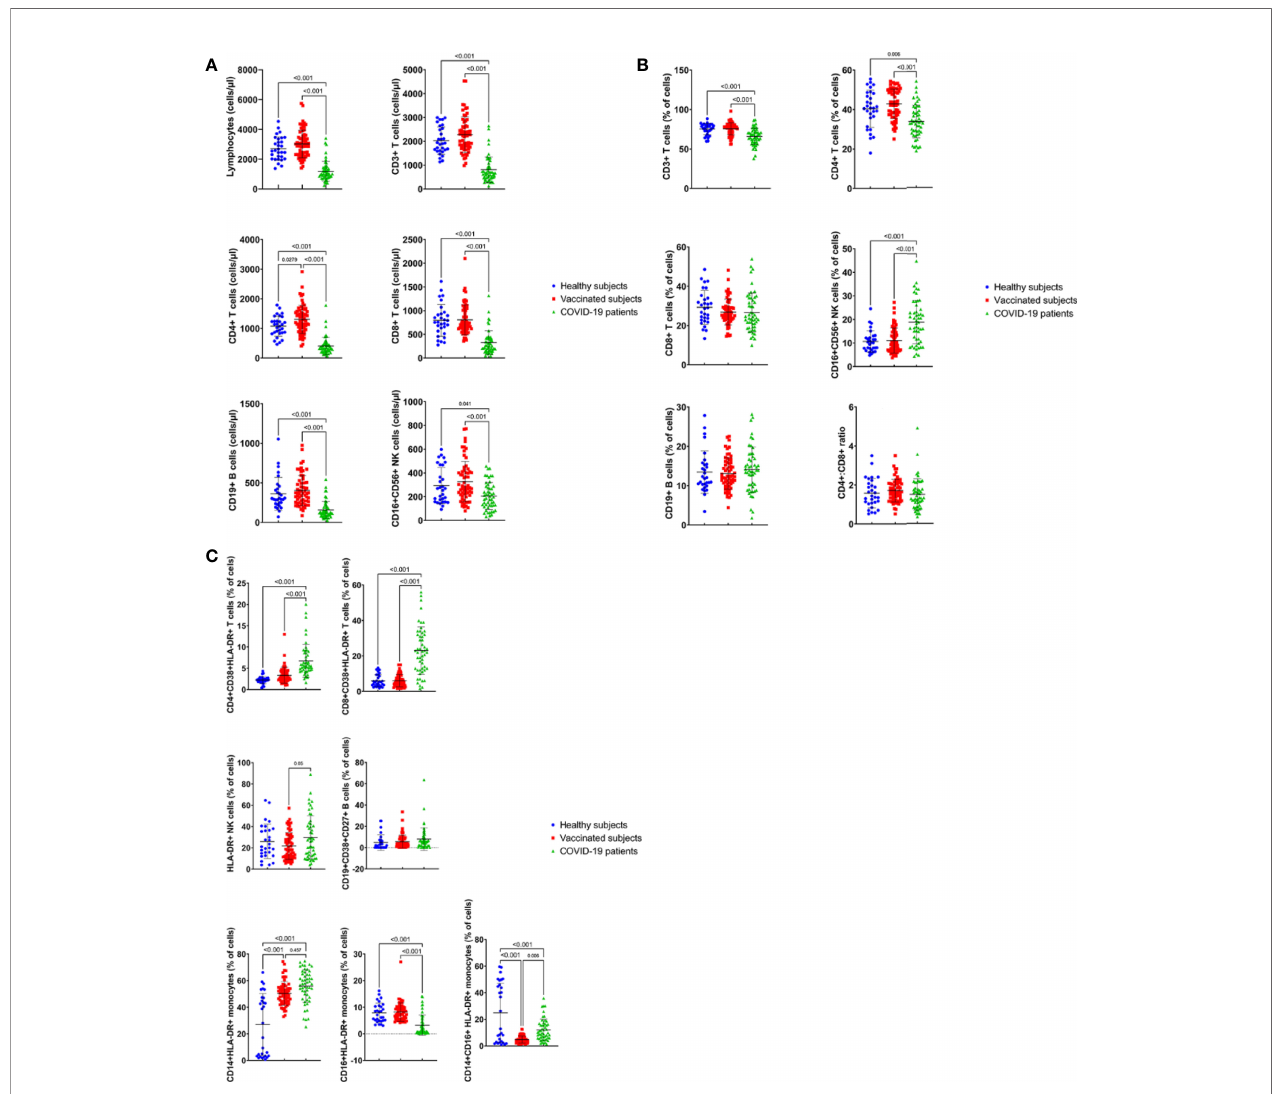
FIGURE 2 | Absolut counts (cells/ m l) (A) and percentages (B) of immune cell subsets in peripheral blood of COVID19-infected patients, healthy subjects and vaccinated subjects. Results are shown for total lymphocytes, CD3+, CD4+ and CD8+ T cells, CD19+ B cells and CD16+CD56+ NK cells and CD4:CD8 ratio. Each dot represents an individual donor. Data are presented as mean + SEM. (C) Percentage of activated immune cell subsets in peripheral blood of COVID19-infected patients, healthy subjects and vaccinated subjects. Results are shown for CD38+HLA-DR+CD4+ and CD38+HLA-DR+CD8+ T cells, CD27+CD38+CD19+ B cells and monocytes subsets: CD14+HLA-DR+, CD16+HLADR+ and CD14+CD16+HLA-DR+ cells. Data are presented as mean +